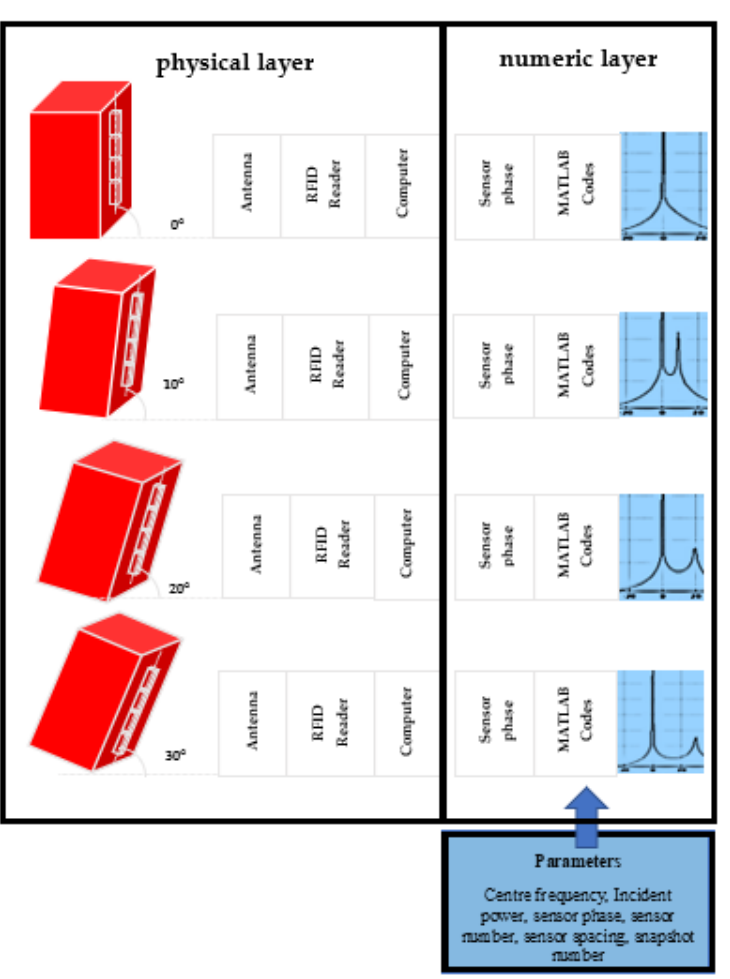
Figure 7. DOA estimation using the MUSIC algorithm with RFID tags for SHM.